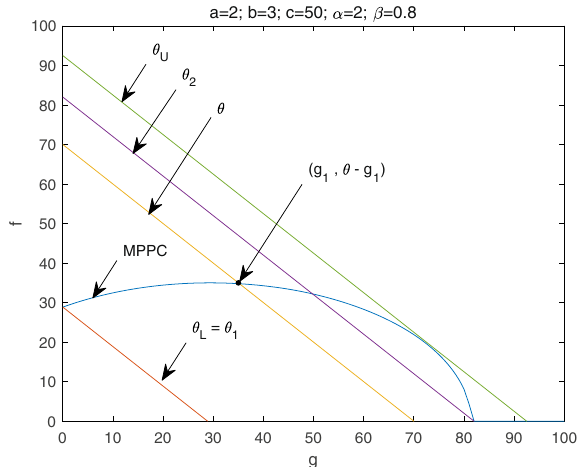
Fig. 8 The intersections ( g 3 , θ - g 3 ) and ( g 4 , θ - g 4 ) when max( θ 1 , θ 2 )< θ < θ U